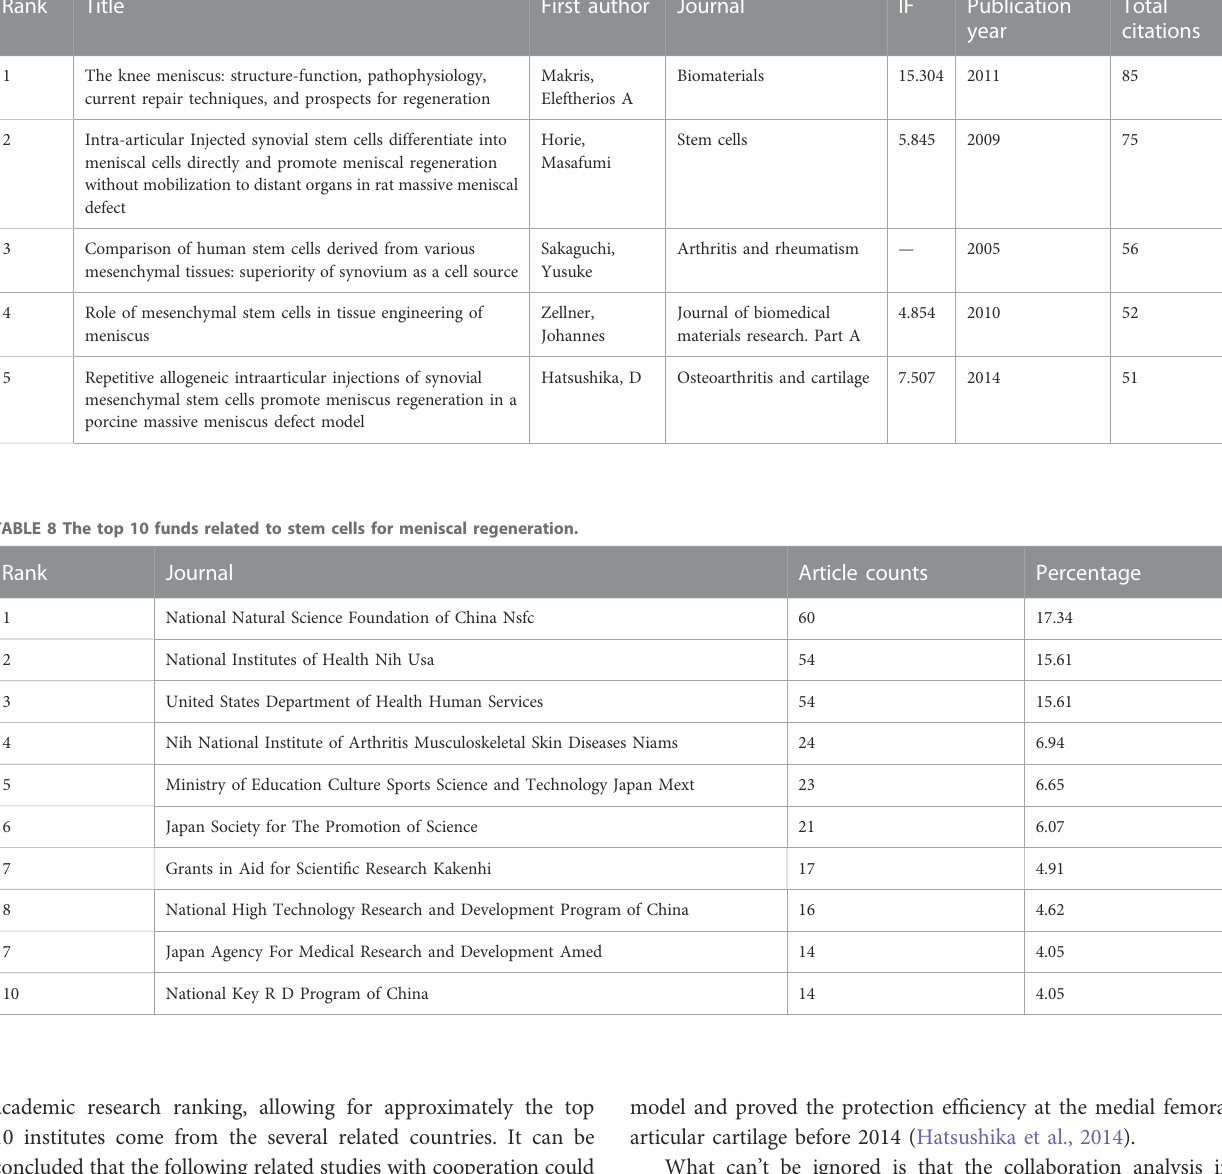
Figure 6B indicated a shortage of academic collaboration and